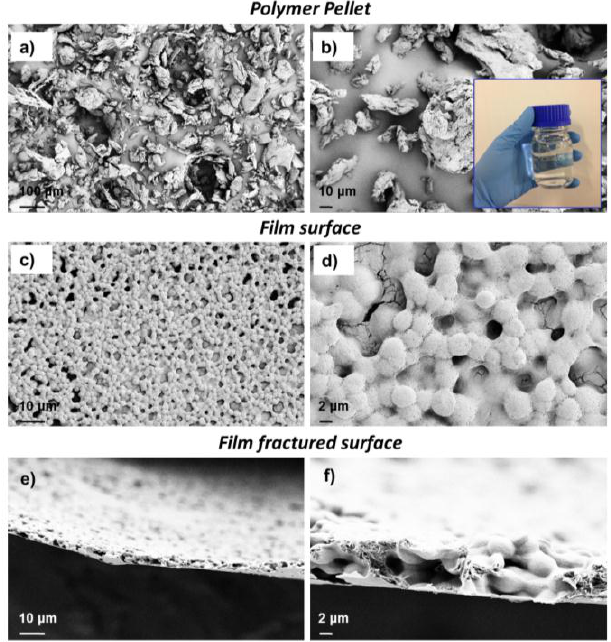
Figure 1. FESEM investigation of chitosan pellet ( a , b ), surface ( c , d ), and fractured surface of the